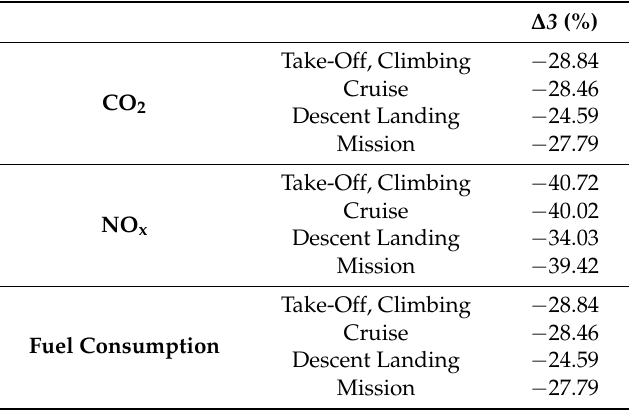
Figure 19. Electrical scheme of the hybrid propulsion system.